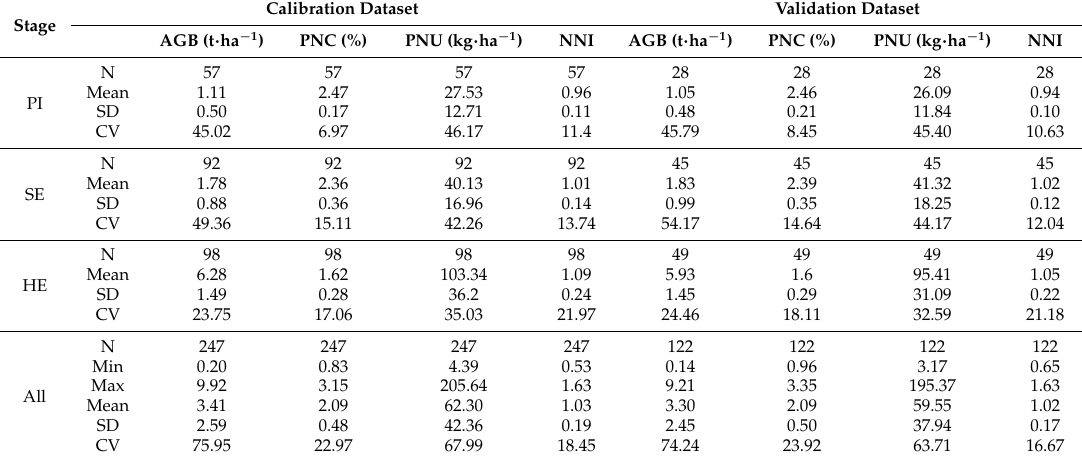
Table 4. Descriptive statistics of the measured aboveground biomass (AGB), nitrogen